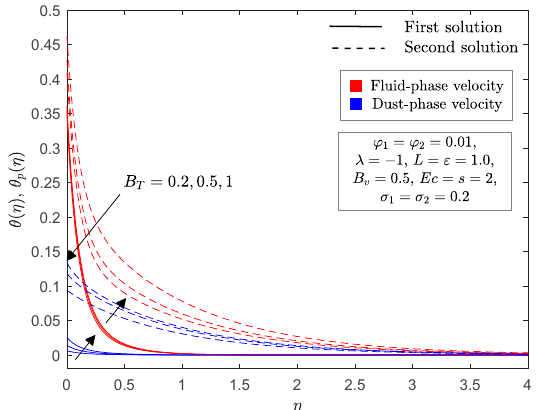
( ) ( ) θη θ η for selected values of , p ( η ) for selected values of B T .